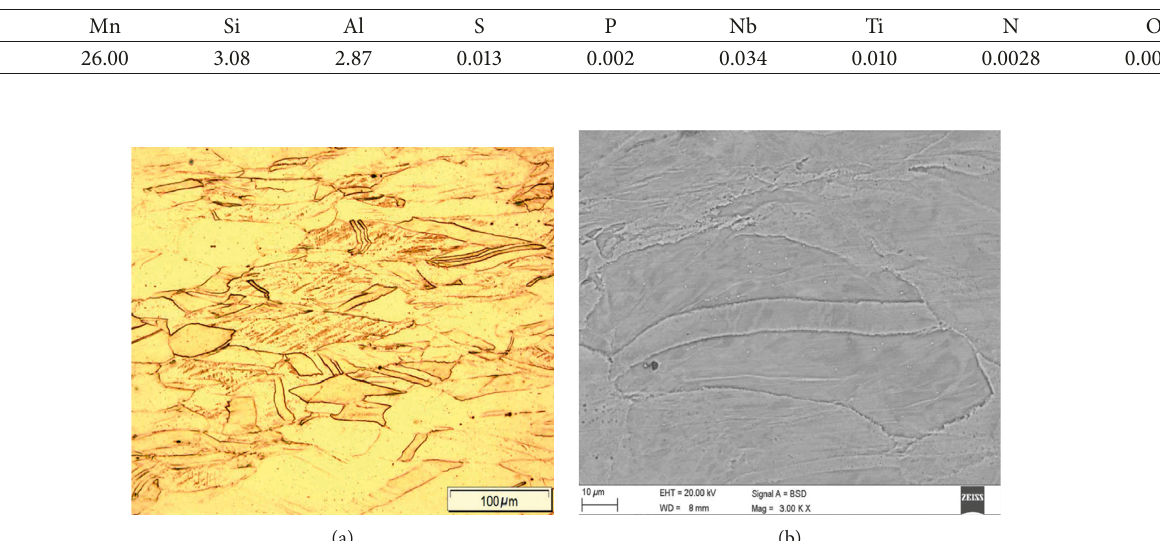
Figure 1: Optical micrograph (a) and SEM image (b) of the X6MnSiAlNbTi26-3-3 steel before tensile